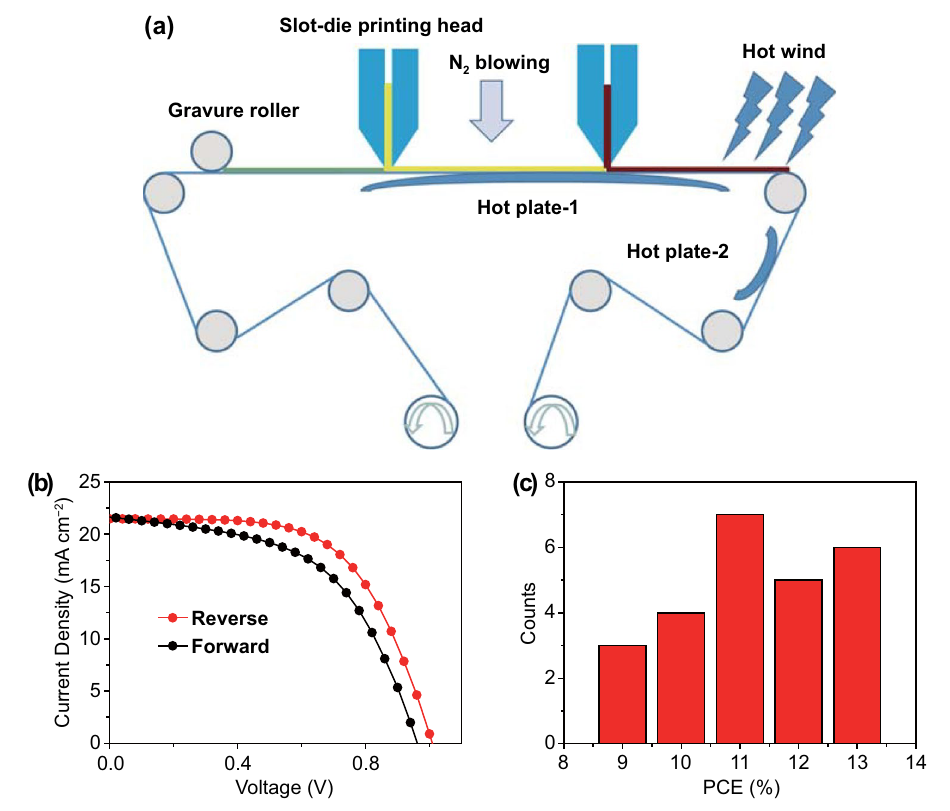
Fig. 6 a R2R processing set-up for continuous preparation of PSCs. b J–V curves for the champion device fabricated by R2R coating. c The dis- tribution of PCEs obtained from R2R processed 25 devices